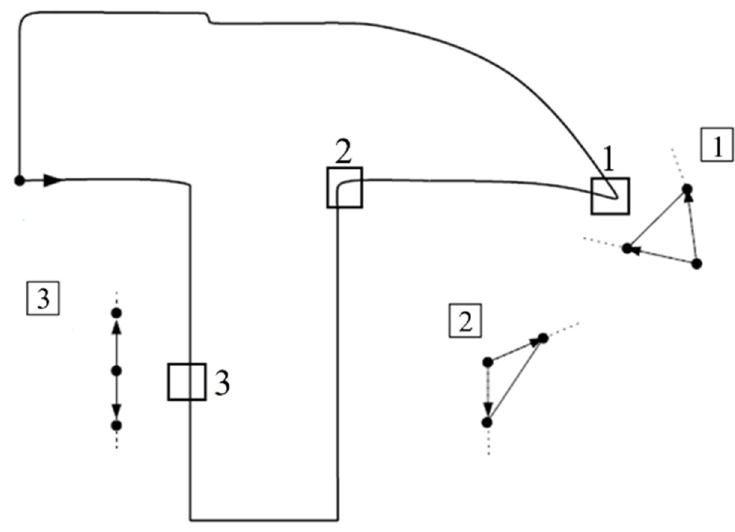
Figure 3. Triangular regions of a closed contour [25].